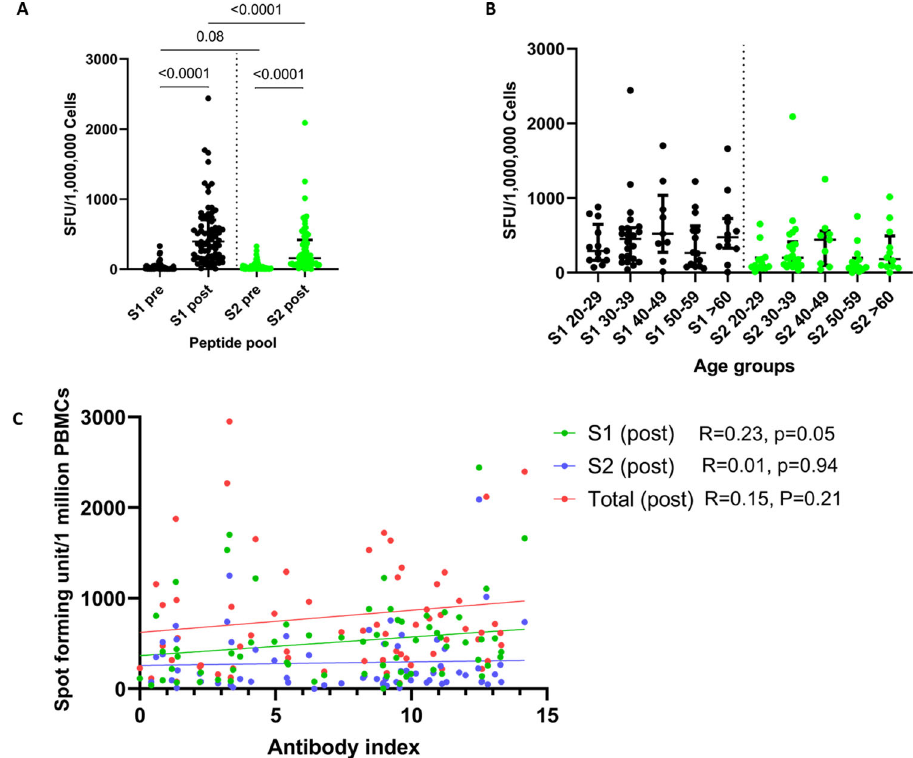
Fig. 4 Ex vivo IFN γ ELISpot responses in individuals at baseline and 28 – 32 days following a single dose of the AZD1222/Covishield vaccine. Ex vivo IFN γ ELISpot responses were measured to two pools representing the spike protein (S1 and S2) at the baseline (pre) and 28 – 32 days following the vaccine in total naïve individuals ( n = 72) ( A ), and in different age sub-groups of naïve individuals ( n = 68) ( B ). The association of the ex vivo IFN γ ELISpot responses to the two pools of the spike protein (S1 and S2) and the total responses to overlapping peptides of the spike protein did not correlate with the total antibody responses ( n = 68) ( C ). The Wilcoxon matched-pairs signed-rank test was used to compare the means of ex vivo ELISpot responses to S1 and S2 pool of peptides before and after the vaccine. The Kruskal – Wallis test was used to compare the S1 and S2 ELISpot responses in different age groups. Spearman rank order correlation coef fi cient was used to evaluate the correlation between the ex vivo ELISpot responses and the SARS-CoV-2-speci fi c antibodies (antibody index). All tests were two sided. Data are presented as median values ± interquartile ranges as